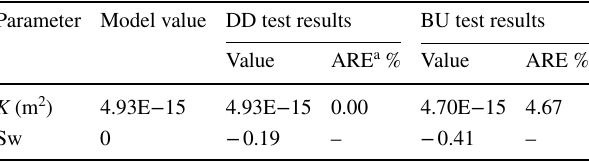
Table 2 Results of DD1 and BU1 tests using normalized two-phase pseudo-pressure (case